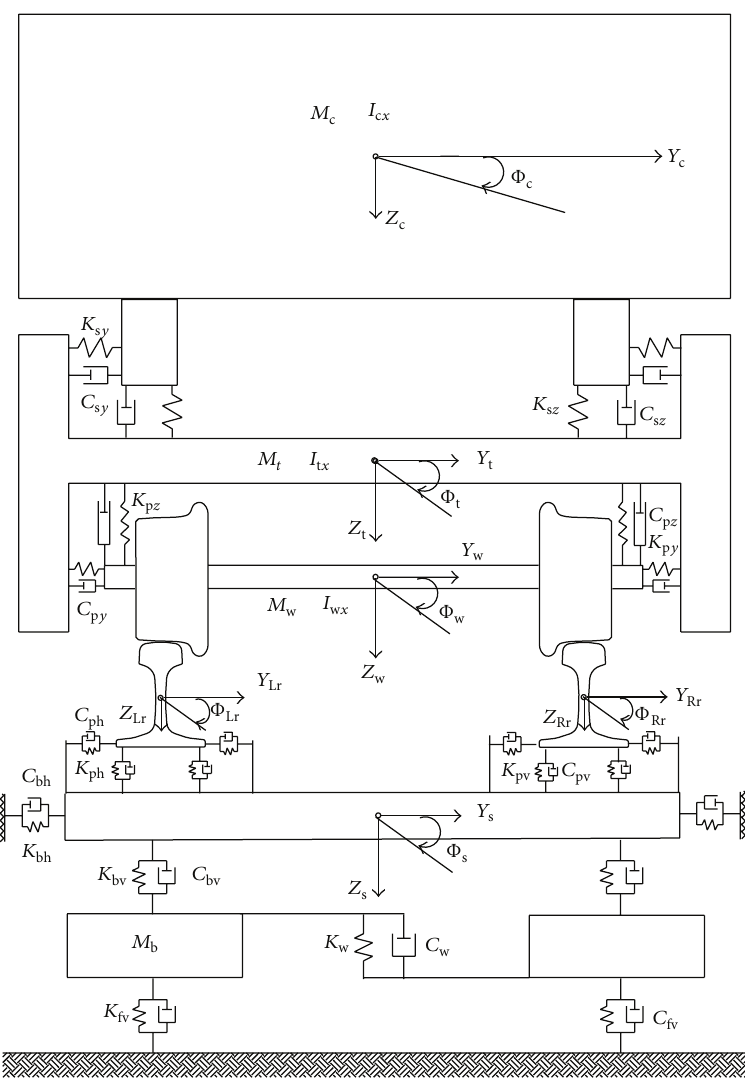
Figure 7: Three-dimensional vehicle-track coupled dynamic model (end view).